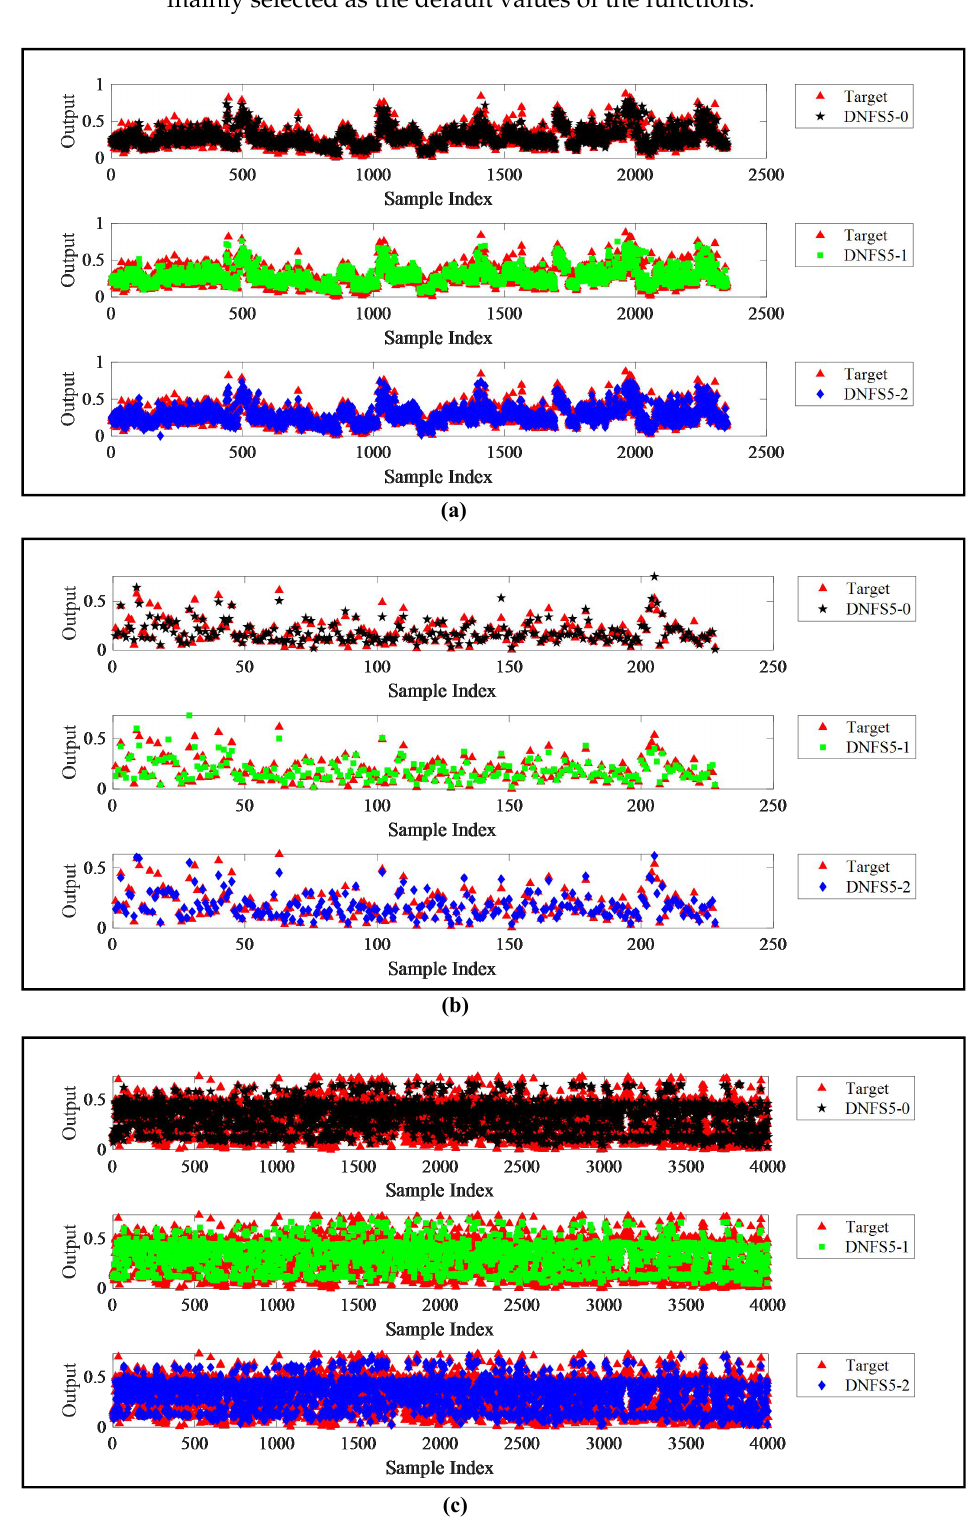
Figure 4. Prediction chart of DNFSs with different shared inputs on the three test datasets. ( a ) Test Dataset No. 1. ( b ) Test Dataset No. 2. ( c ) Test Dataset No.